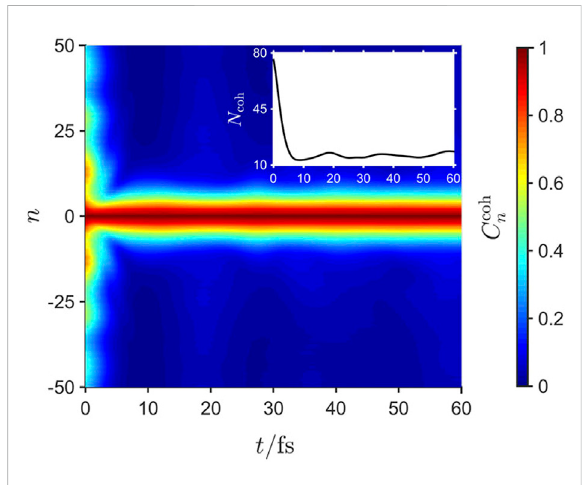
The time dependence of the exciton coherence correlation function, C coh n , Eq. 24. The time dependence of the associated coherencenumber, N coh (Eq.25),isshownintheinset. N coh decays within 10 fs, i.e., within half a vibrational period. Reproduced fromJ. Chem.Phys.148,034901(2018)with thepermissionofAIP